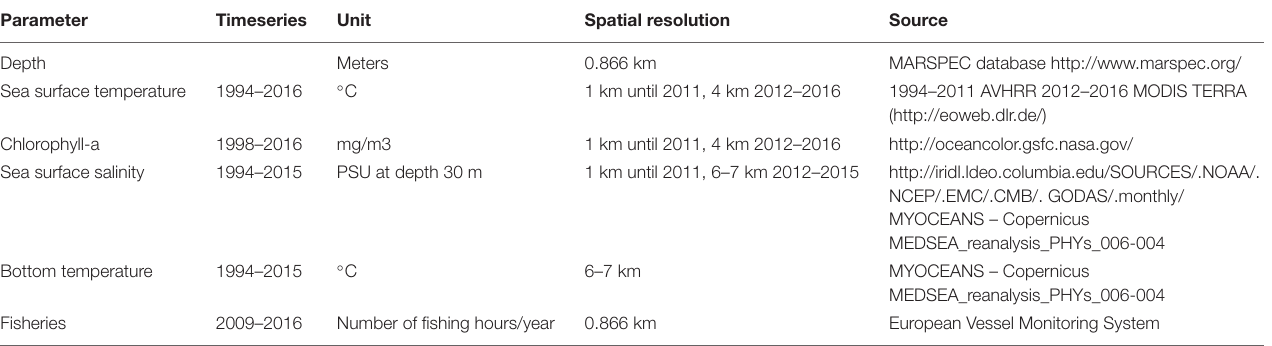
TABLE 2 | Abiotic and fishery data collected and relative data